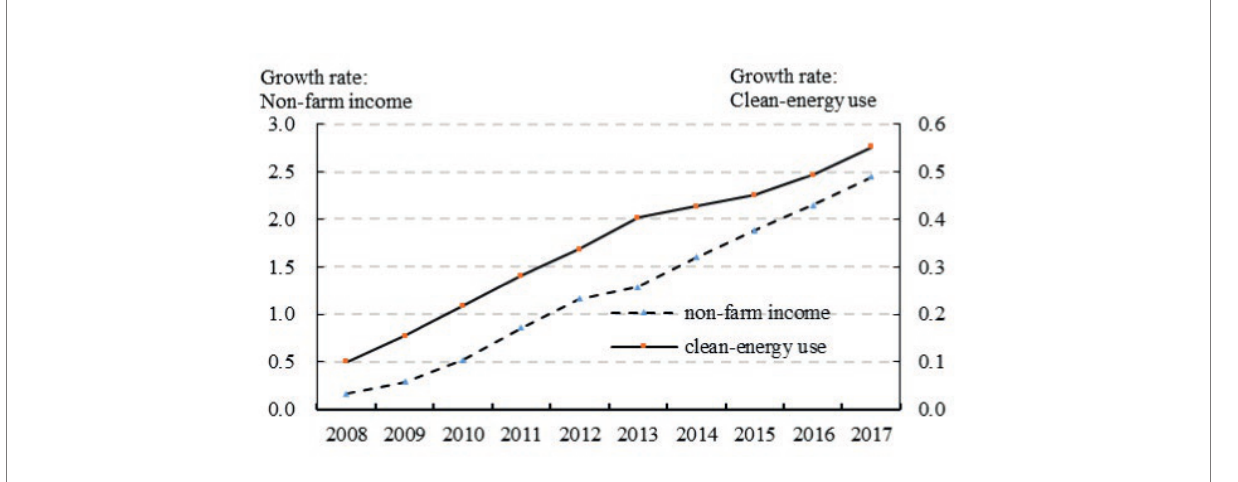
FIGURE 3 Trends in non-farming income and clean energy use